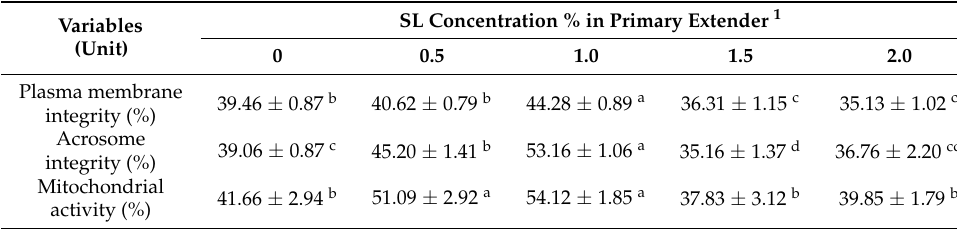
Table 2. Percentages of plasma membrane and acrosome integrities, and mitochondria activity of post- thawed rooster sperm treated with different concentrations of soybean lecithin (SL) (n = 20 roosters and n = 95 ejaculate).